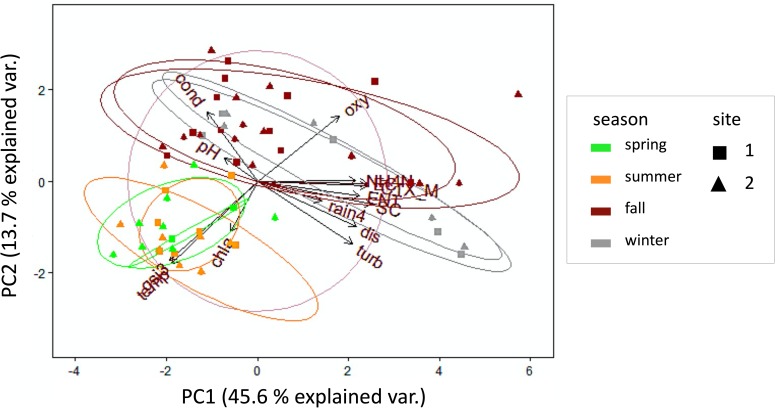
PCA biplot of blaCTX-M genes, FIO and environmental parameters.Site 1 data are indicated by squares, site 2 data are indicated by triangles. Data are grouped by seasons (cellipses); (circle = correlation circle, chla: chlorophyll-a, cond: conductivity, CTX_M: blaCTX-M genes, dis: discharge, EC: E. coli, ENT: intestinal enterococci, gsi3: 3-day-sum of global solar irradiance, NH4N: ammonium-nitrogen, oxy: oxygen, rain4: 4-day-sum of rainfall, SC: somatic coliphages, temp: water temperature, turb: turbidity).